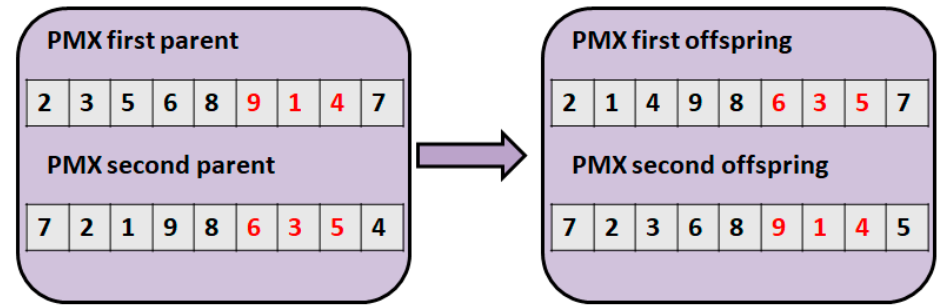
Figure 5. The partially matched crossover (PMX).